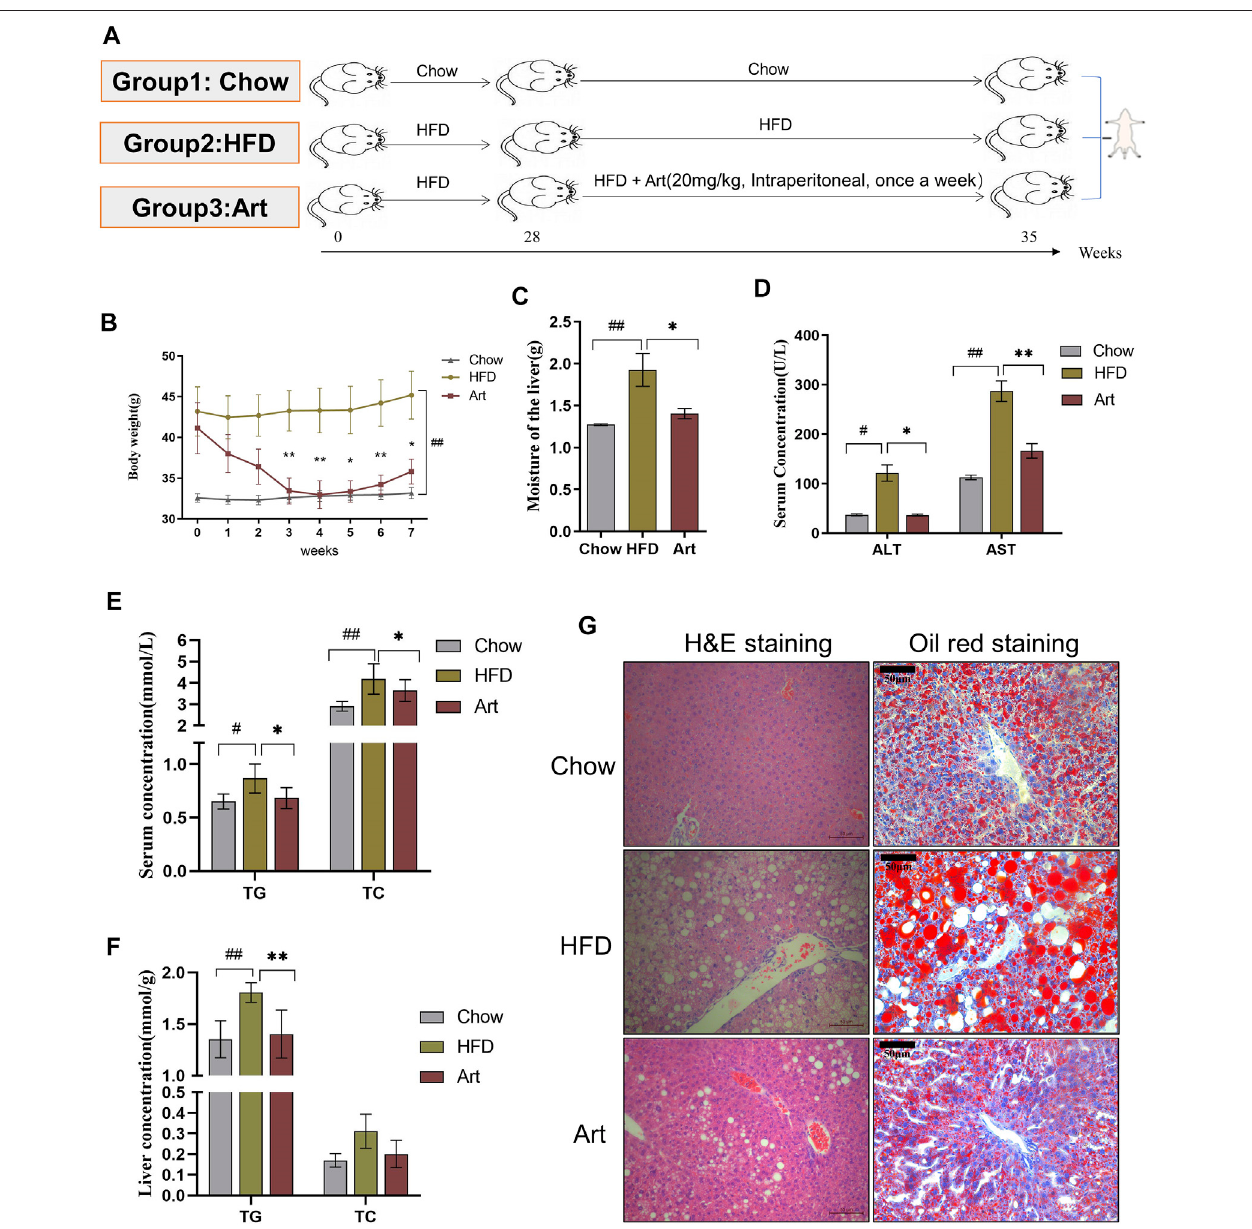
FIGURE2| ArtemetherimproveshepaticsteatosisandliverinjuryinNASHmiceinducedbyaHFD. (A) Experimentdesignwasdividedintothreegroups:chowdiet group (Chow), high-fat diet group (HFD), and high-fat diet combined with the artemether treatment group (Art): 20 mg/kg BW intraperitoneally once a week for 7 weeks ( n =6). (B) Body weight changeafter dosing. (C) Liver weight. (D) Serum ALT and AST levels. (E) Serum TGand TClevels. (F) TG and TC concentrationsin the liver. (G) Fromlefttoright,H&Estainingoftheliver(scalebar,50 μ M)andoilredOstainingoftheliver(scalebar:50 μ M).TheChowgroupvs.theHFDgroup: # p < 0.05, ## p < 0.01, and ### p < 0.001. The Art group compared with the HFD group: * p < 0.05, ** p < 0.01, and *** p < 0.001.